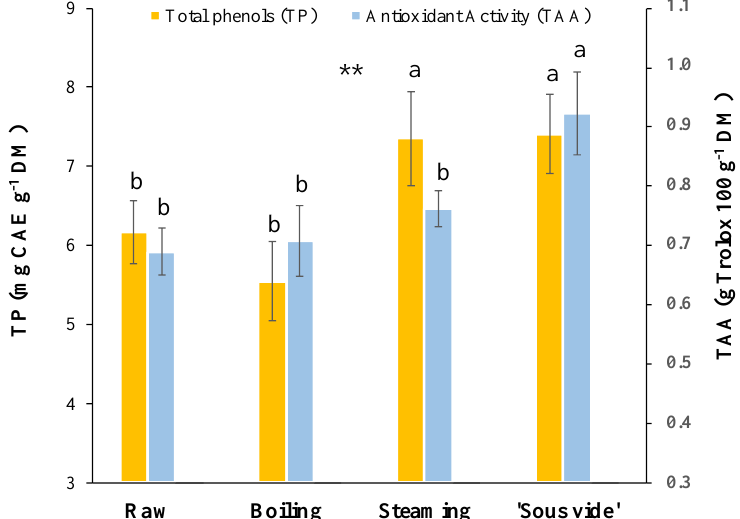
Figure 2. Total phenols (TP) content and total antioxidant activity (TAA) in golden thistle midribs raw and cooked by boiling, steaming, and ‘sous vide’. Vertical bars indicate the standard deviation. Different letters indicate statistically different values ( α = 0.05) between treatments. Significance: **, significant at p ≤ 0.01.